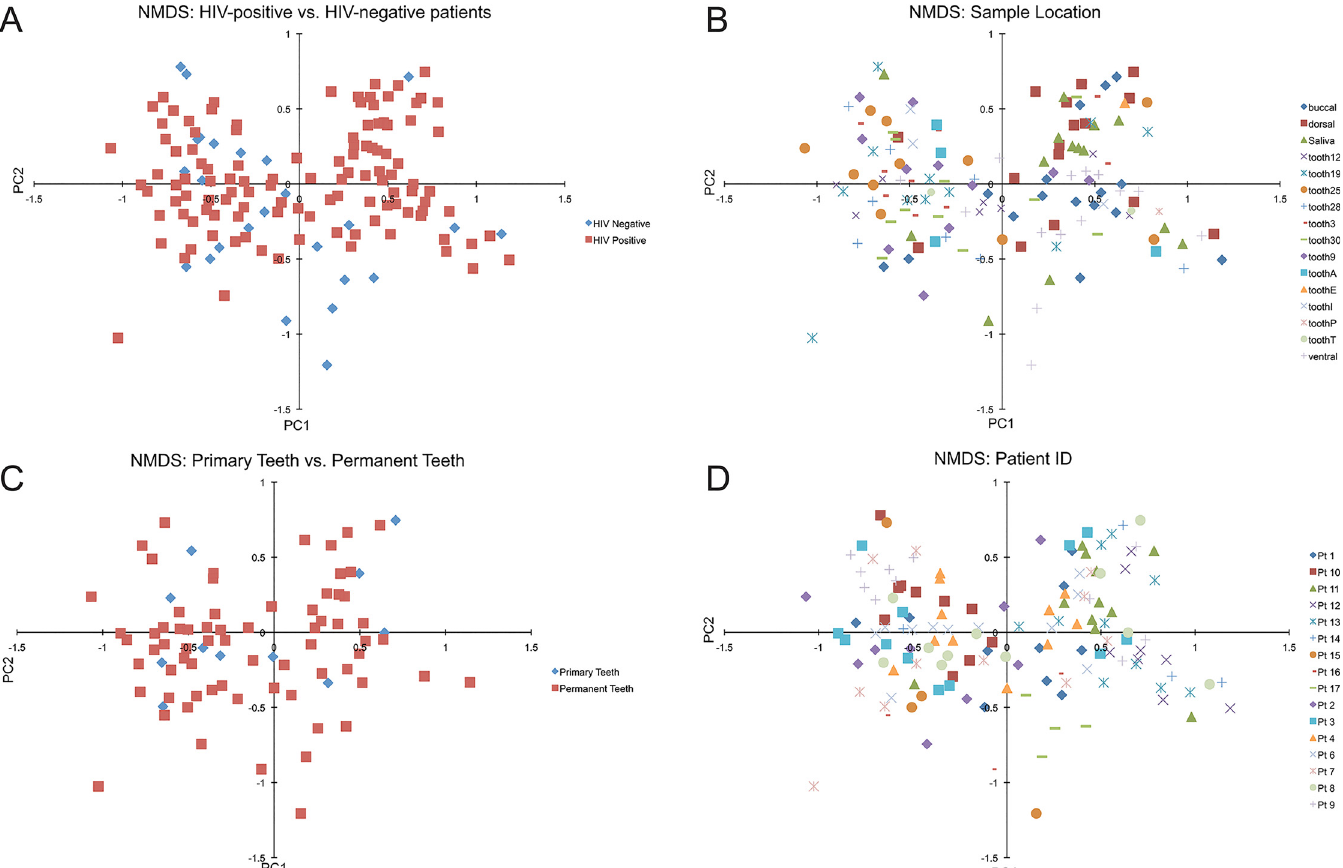
Fig 5. NMDS Coordinate Plots. NMDS plots were generated using OTU abundance data using the Vegan package in R. Panel A and B contain coordinates labeled by HIV status and sample location respectively, while Panel C and D contain coordinates labeled by dentition status and patient ID.